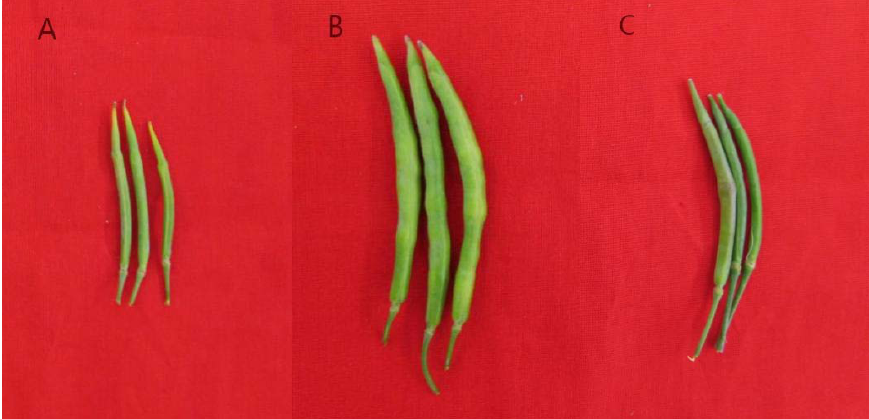
Figure 6. Pod enlargement of self ‐ compatibility lines 18 ‐ 2169 ( B ) and self ‐ incompatibility lines 18 ‐ 512 ( A ) and 18 ‐ 2170 ( C ) in the open flower stage.